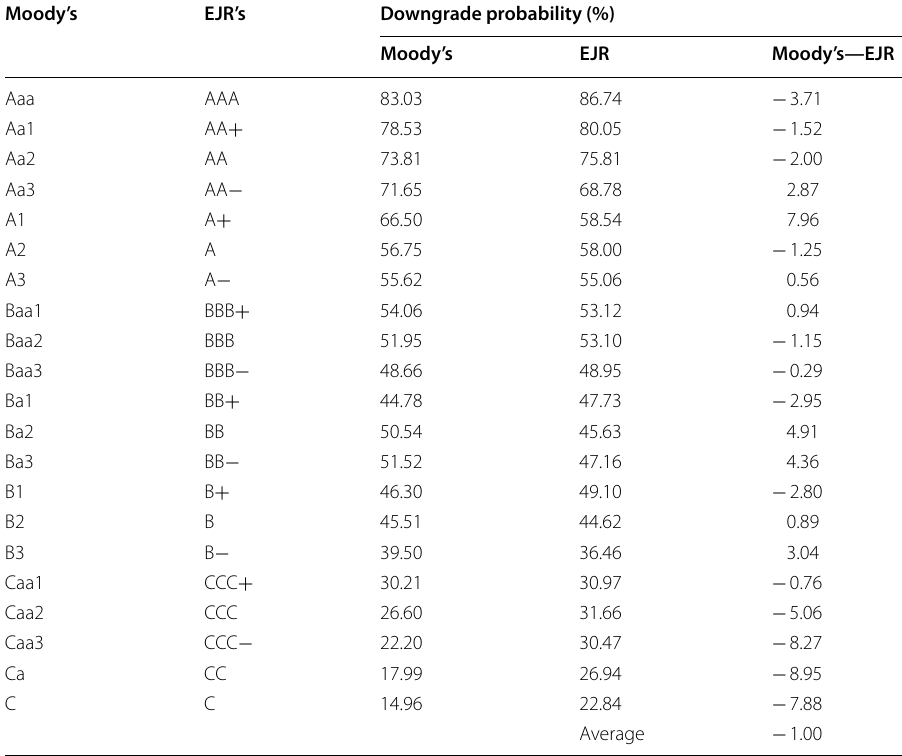
Table 3 Downgrade probability of Moody’s and EJR’s ratings Moody’s